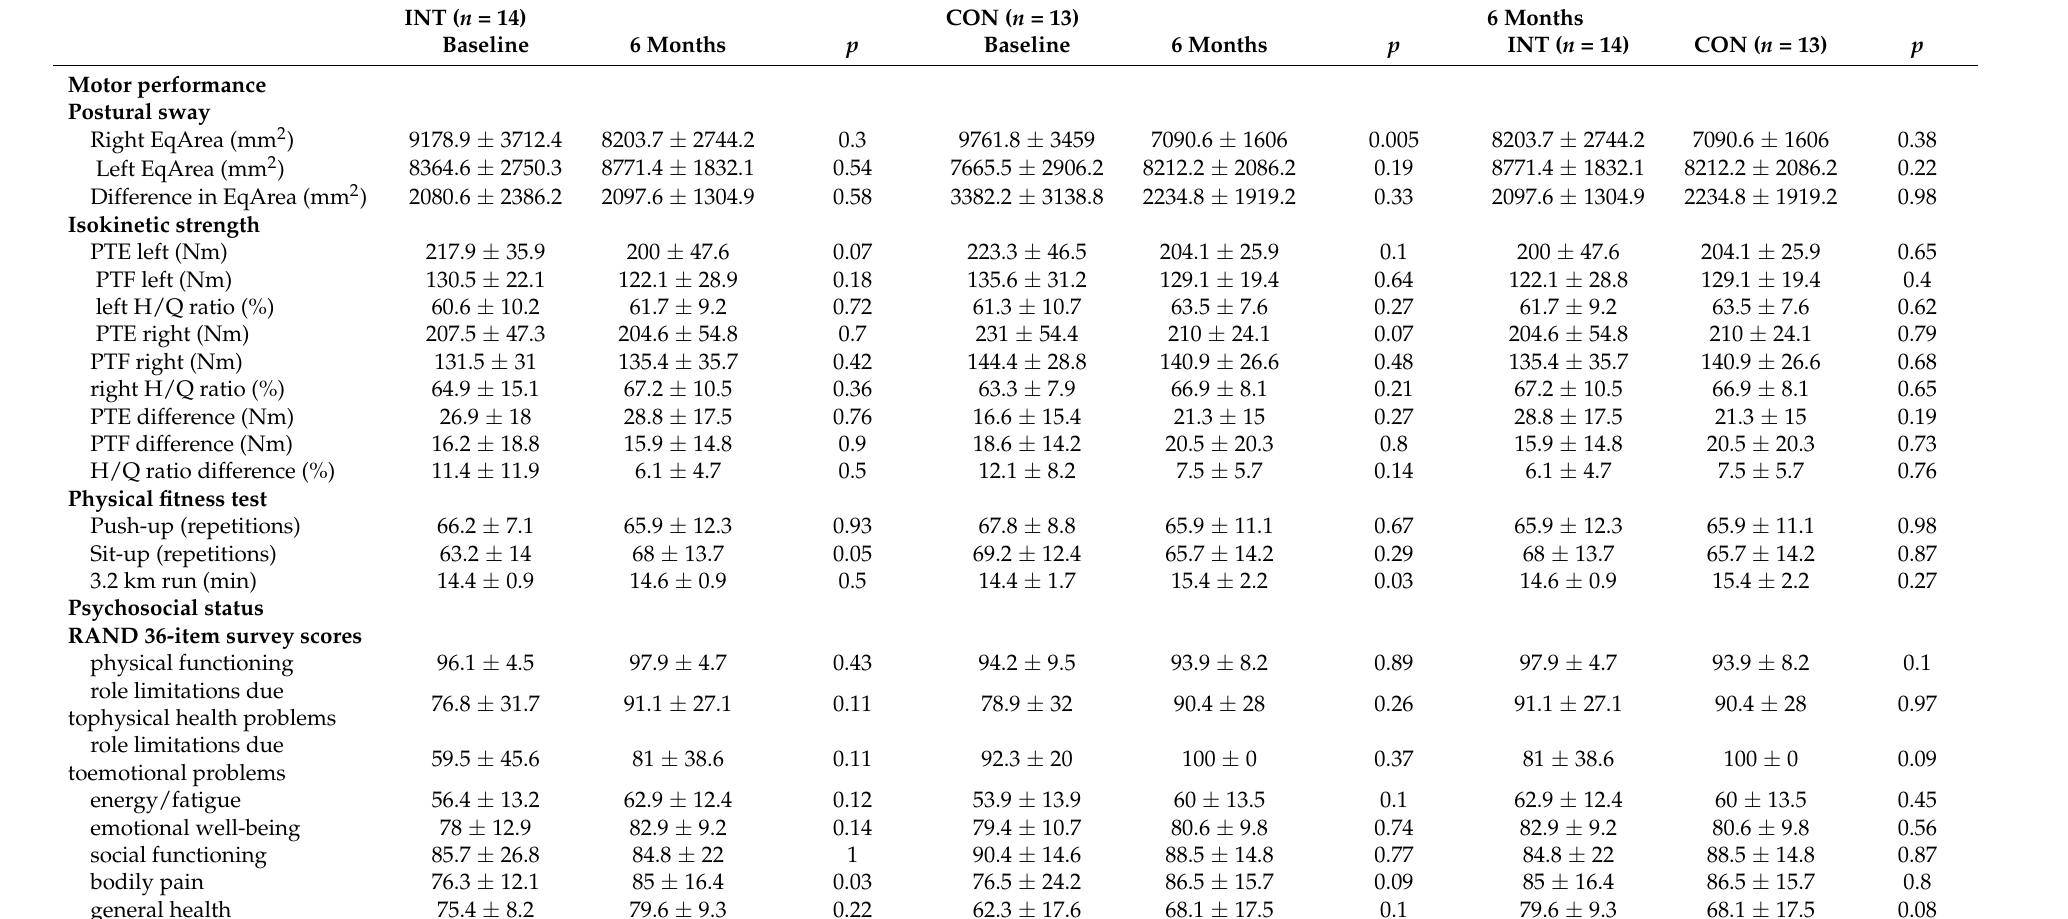
Table 4. Motor performance and psychosocial